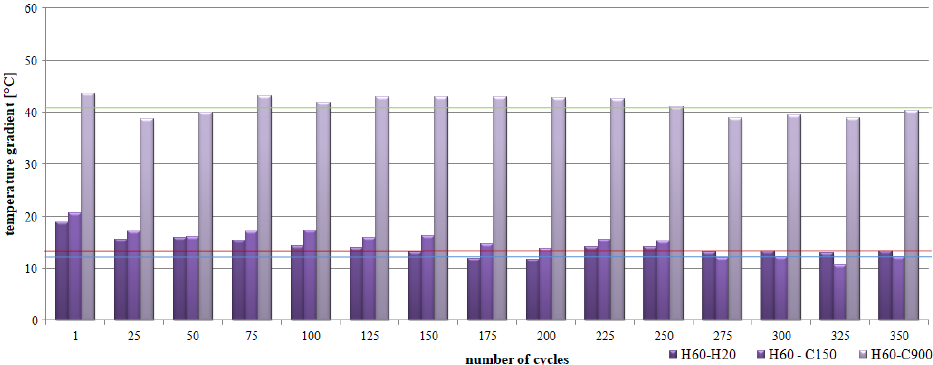
Figure 14. Gradient of the average temperature of the CC-2 concrete depending on the number of thermal cycles and the research period.